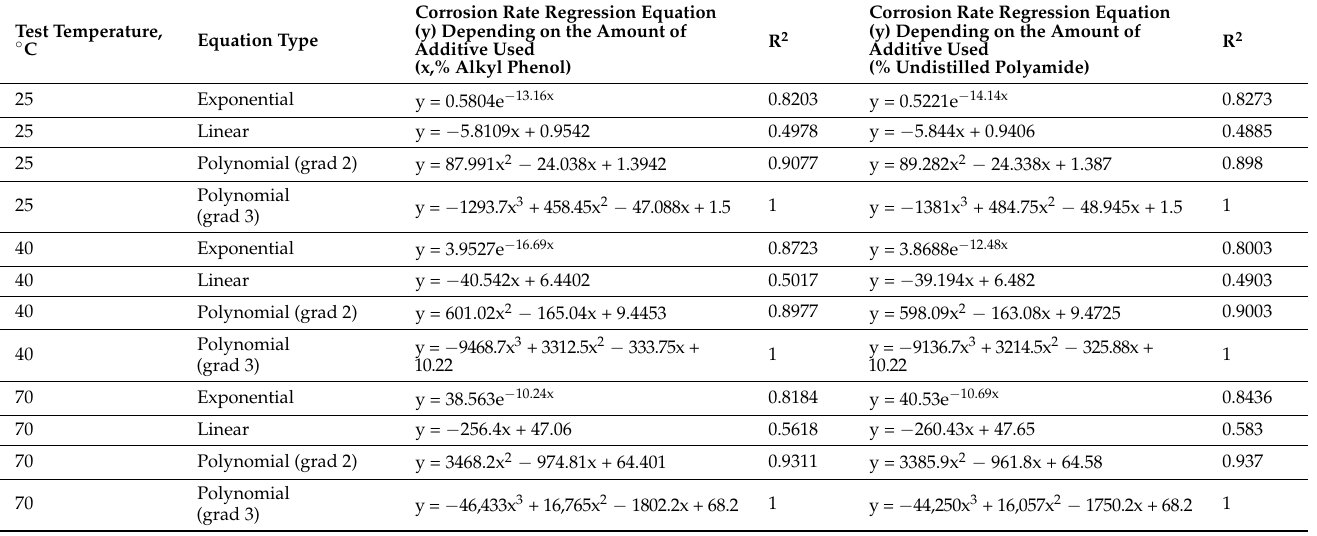
Table 10. Corrosion rate equations (y) as a function of temperature, HCl content of the solution (15%), and the amount of antacid additive used (x,%).